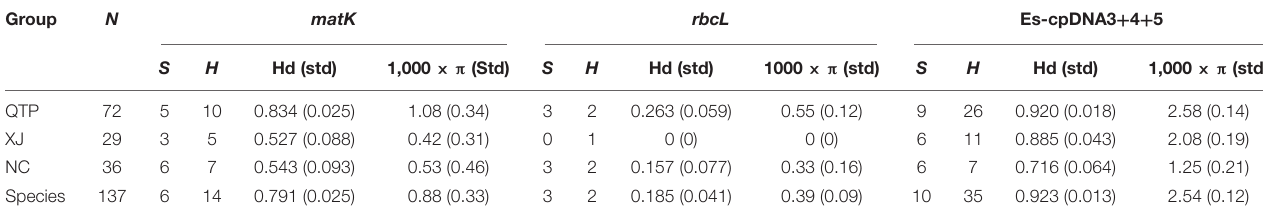
TABLE 3 | Genetic diversity of Elymus sibiricus estimated by cpDNA.